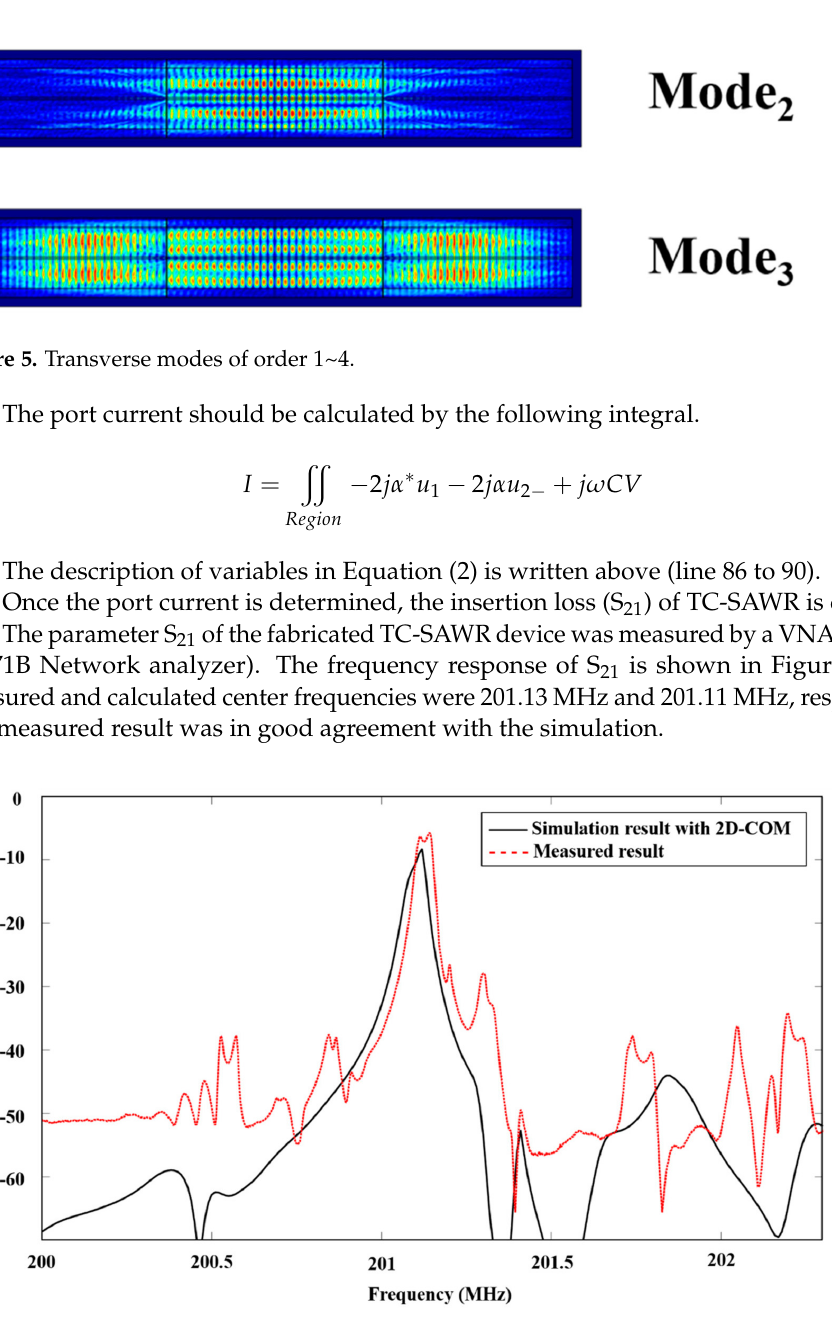
Figure 6. Insertion loss (S 21 ) of TC-SAWR calculated by using 2D-COM (black solid curve) and measured (red dotted